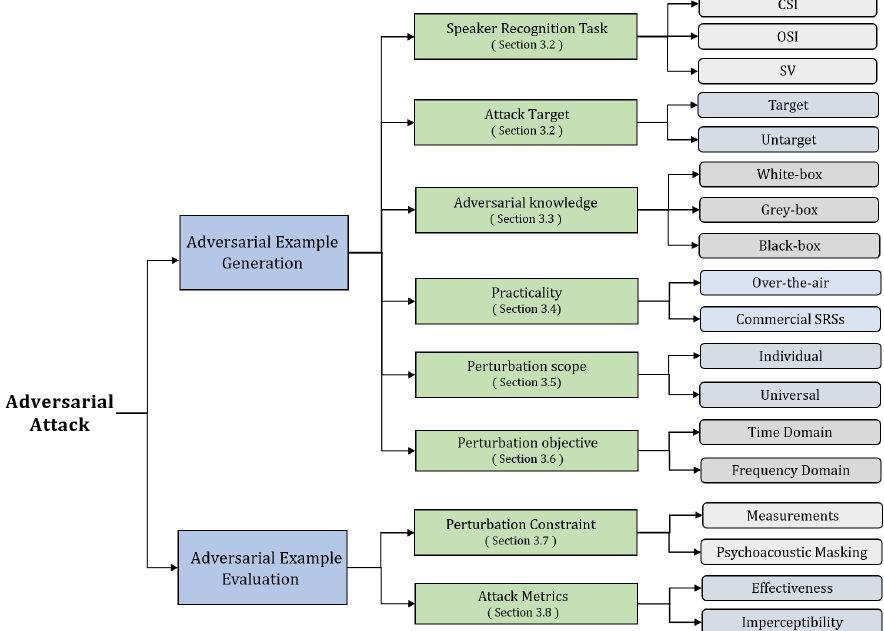
Figure 4. Taxonomy of adversarial audios in